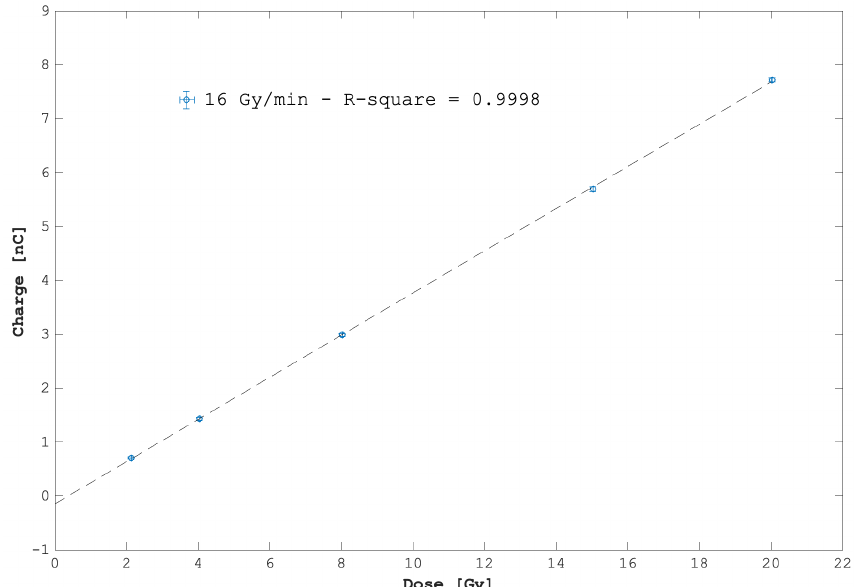
Figure 4. Detector response as a function of the released dose in water. The linear fit shows an excellent confidence degree expressed by the R2 parameter.